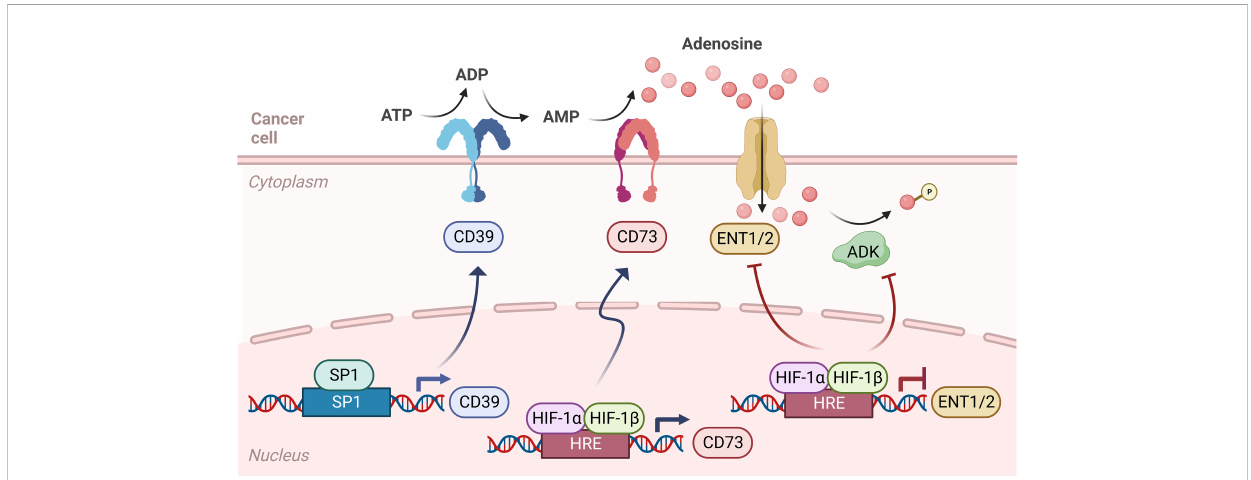
FIGURE 2 Adenosine signaling pathway during hypoxia. Adenosine signaling in hypoxia is similar to normoxia, as ATP is converted to ADP and AMP by CD39, then converted to adenosine by CD73. However, in hypoxic cancer cells, the transcription of CD39 is upregulated through Sp1, leading to more ADP and AMP in the tumor microenvironment (TME). Also, while levels of HIF-1 a are kept low by the Von Hippel-Lindau (VHL) tumor suppressor in normoxic conditions, in hypoxia HIF-1 a stabilizes and binds to HIF-1 b , which forms a complex that enters the nucleus and binds to hypoxia response elements (HRE) on the gene promoter, therefore regulating the transcription of CD73 and equilibrative nucleoside transporters (ENT1/2). In hypoxia, CD73 transcription is upregulated, while ENT1 and ENT2 transcription is downregulated. HIF-1 a also inhibits adenosine kinase and ENTs, leading to an accumulation of adenosine in the TME.